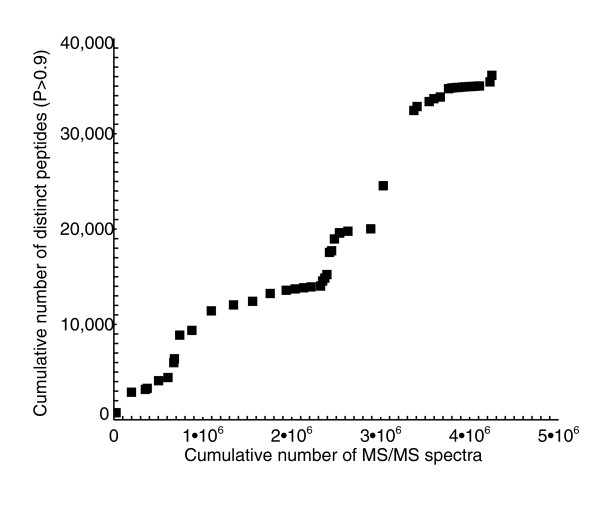
Cumulative number of MS/MS spectra versus the number of unique peptide identifications with P > 0.9. The slope is nearly horizontal in regions of the curve where similar experiments were performed. The curve is expected to show saturation when additional spectra provide no new peptides above P > 0.9. The number of distinct peptides from an in silico trypic digestion of the SGD protein database, allowing one missed cleavage, and counting those peptides whose masses are in the range 500 to 4,000 Da, is 436,445.